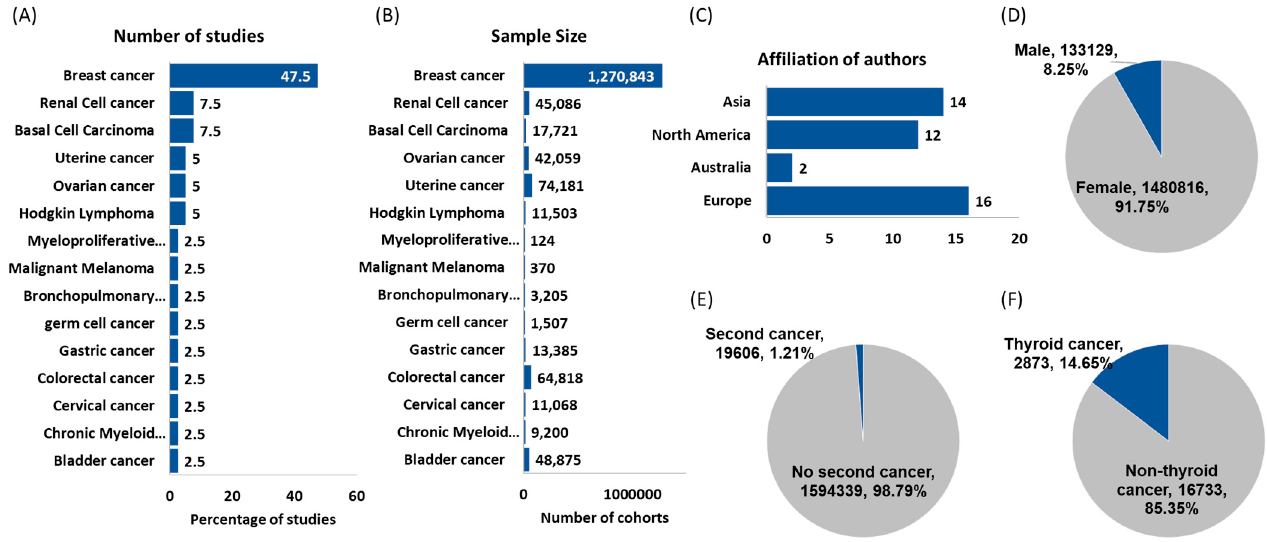
Figure 2. Features of studies and demographics of cancer patients. ( A ) distribution of studies according to the site of primary tumors; ( B ) sample size for each type of primary cancer; ( C ) geographical distribution of studies. Three studies were affiliated by authors from multiple countries; ( D ) distribution of cancer cohorts according to their sex; ( E ) frequency of a second primary cancer following another malignancy; ( F ) frequency of second primary thyroid cancer.